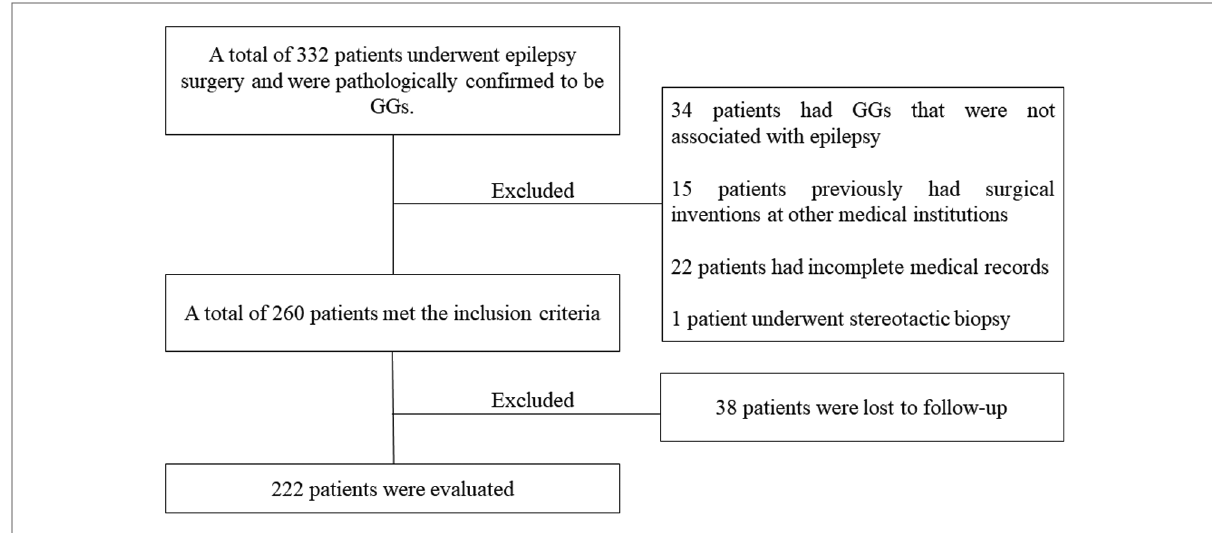
FIGURE 1 The patient-selection